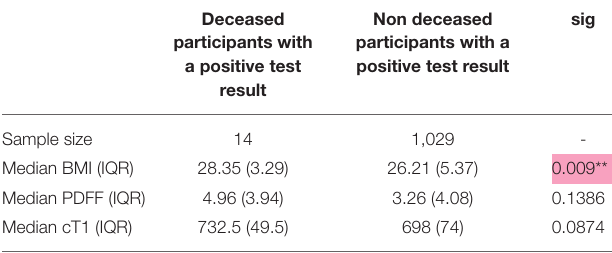
TABLE 3 | Distribution of liver biomarker metrics and BMI in UKB participants who